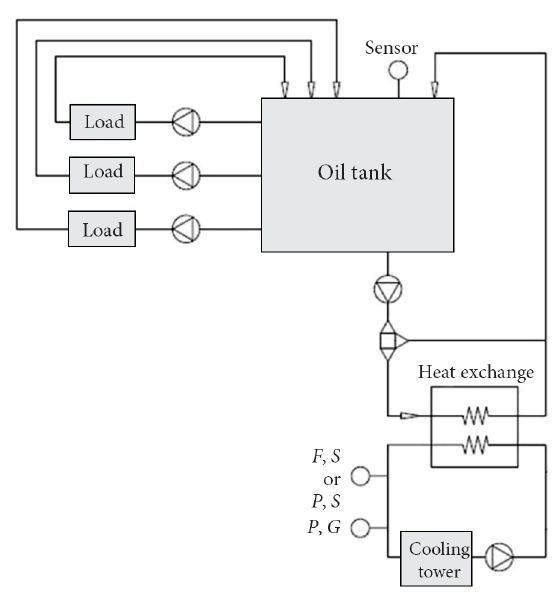
Fig. 10. Circuit of the oil cooling system of the torque generator gearbox